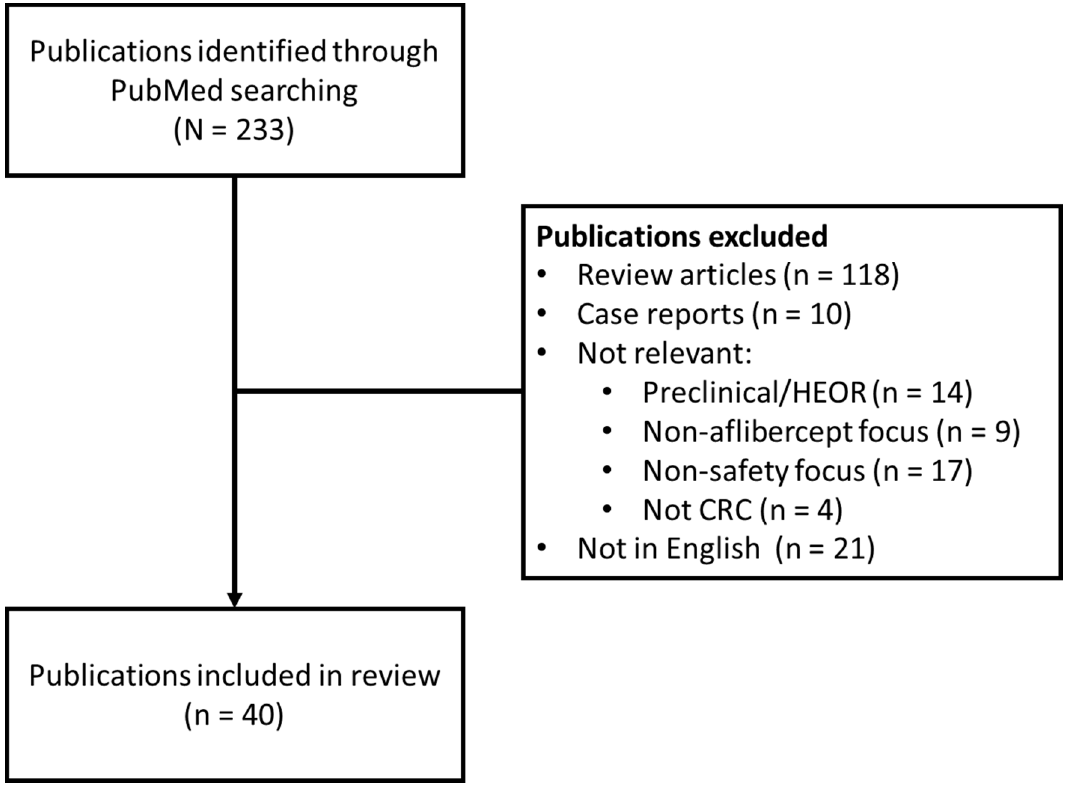
Figure 1. PRISMA flow diagram: summary of literature search outcomes.